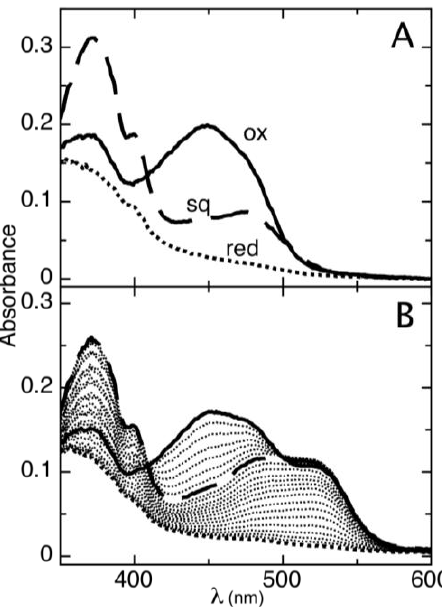
Figure 1. Complete anaerobic reduction of AidB using the xanthine/xanthine oxidase method. ( A ) Representative spectra of the three redox states observed for AidB: oxidized (solid line), anionic semiquinone (dashed line), and reduced (dotted line); ( B ) Reduction of AidB in the presence of the redox dye PS (maximum absorbance at 520 nm), showing spectra collected every ~5 min.